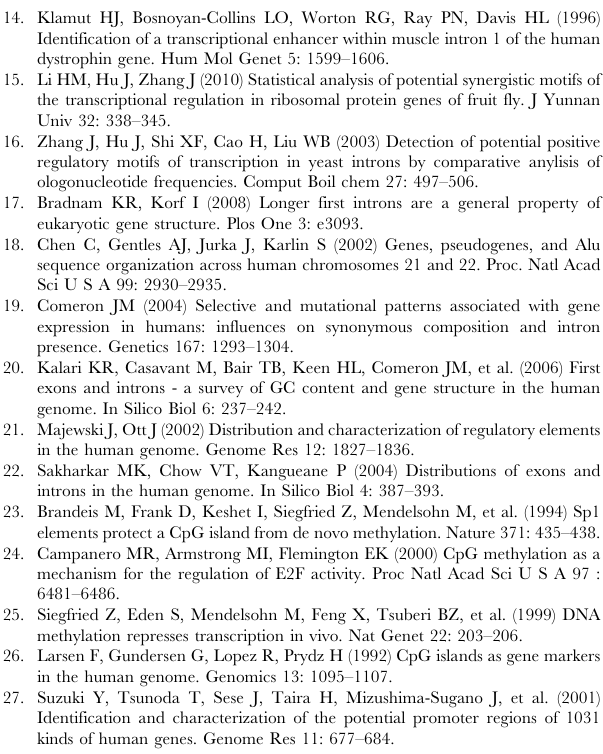
Table S1 List of houskeeping and tissue-specific genes. (XLS) (XLS) Figure S1 Characteristic lengths of introns in housekeeping and tissue-specific genes. (TIF) (TIF) Figure S2 Frequencies of introns overlapped with at least one CpG island in housekeeping and tissue-specific genes. (TIF) (TIF) Figure S3 TATA, CAAT and GC boxes frequencies of introns in housekeeping and tissue-specific genes. (A) Frequency of introns with TATA boxes. (B) Frequency of introns with CAAT boxes. (C) Frequency of introns with GC boxes. (TIF)